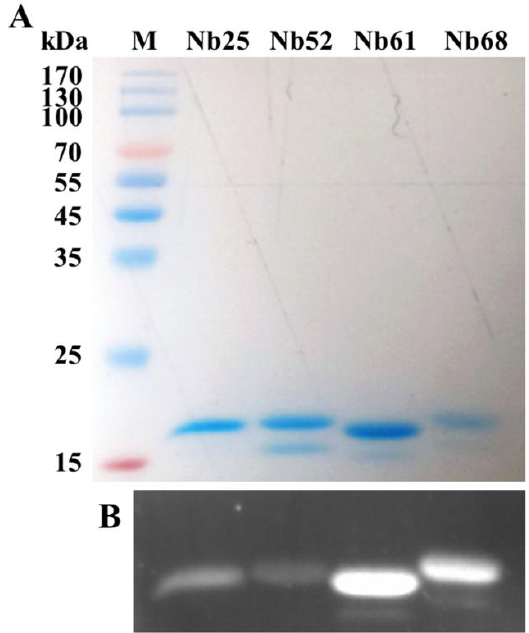
Figure 5. Identification and purification of SARS-CoV-2 S-RBD Nbs. ( A ) SDS-PAGE gel for SARS- CoV-2 S-RBD Nbs (Nb25, Nb52, Nb61, and Nb68). ( B ) Western-blotting assay for confirming the carrying of His-tag of these four Nbs. M: protein marker (10–170 kDa).